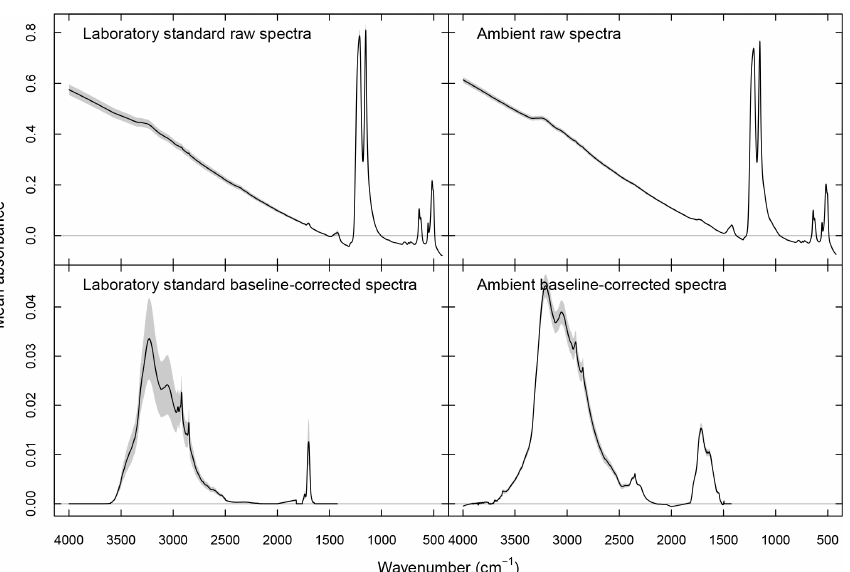
Figure 1. Laboratory and ambient sample spectra (raw and baseline corrected). Black lines denote mean absorbances, and dashed gray areas denote 95% confidence